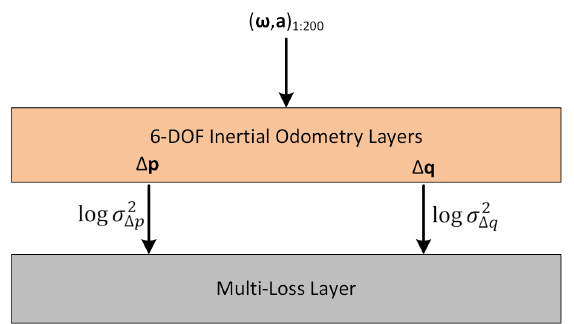
Figure 3. Network architecture with multi-task learning for the translation vector with quaternion. The multi-loss layer allows learning the weights (log variances) associated to each of two tasks (translation and orientation change estimation).